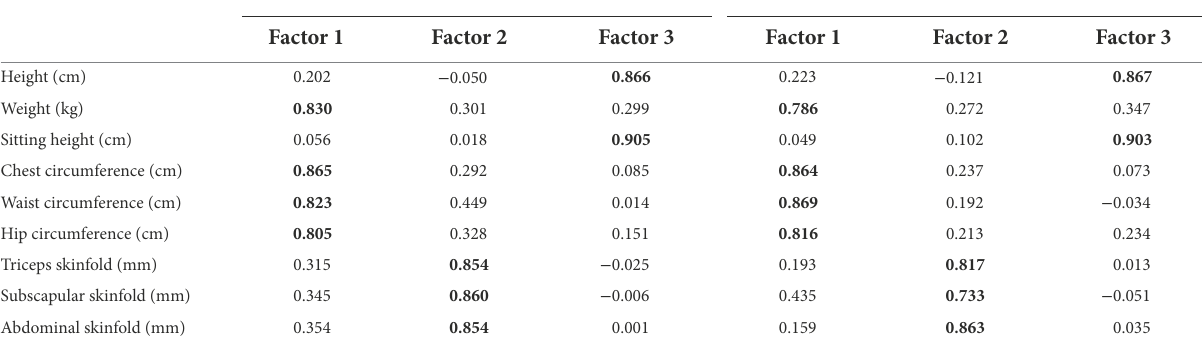
anthropometric data for male and female, respectively. Factor 1 (z 1 ) consisted of BW, CC, WC, and HC. Factor 2 (z 2 ) identified three skinfold measures of triceps, subscapular, and abdominal thickness. Factor 3 (z 3 ) included two measures of height which were standing height and sitting height. Factor loadings of the extracted anthropometric measures were above 0.7. The standardized (z-score) models for male and female students were presented as Equations 7-1, 7-2, respectively. Table 2 indicated factor loadings of the anthropometric measures for male and female students.